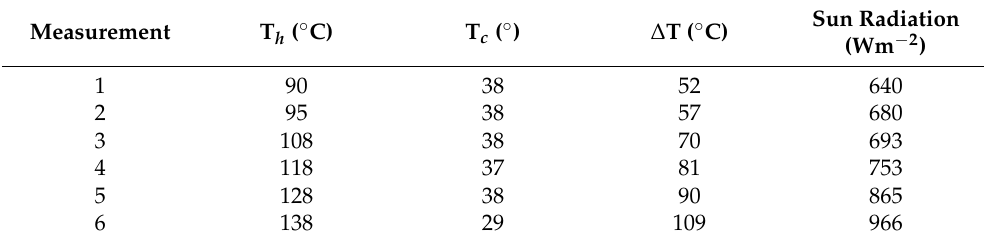
Table 1. Measurement list with hot, cold and temperature gradients together with measured sun radiation